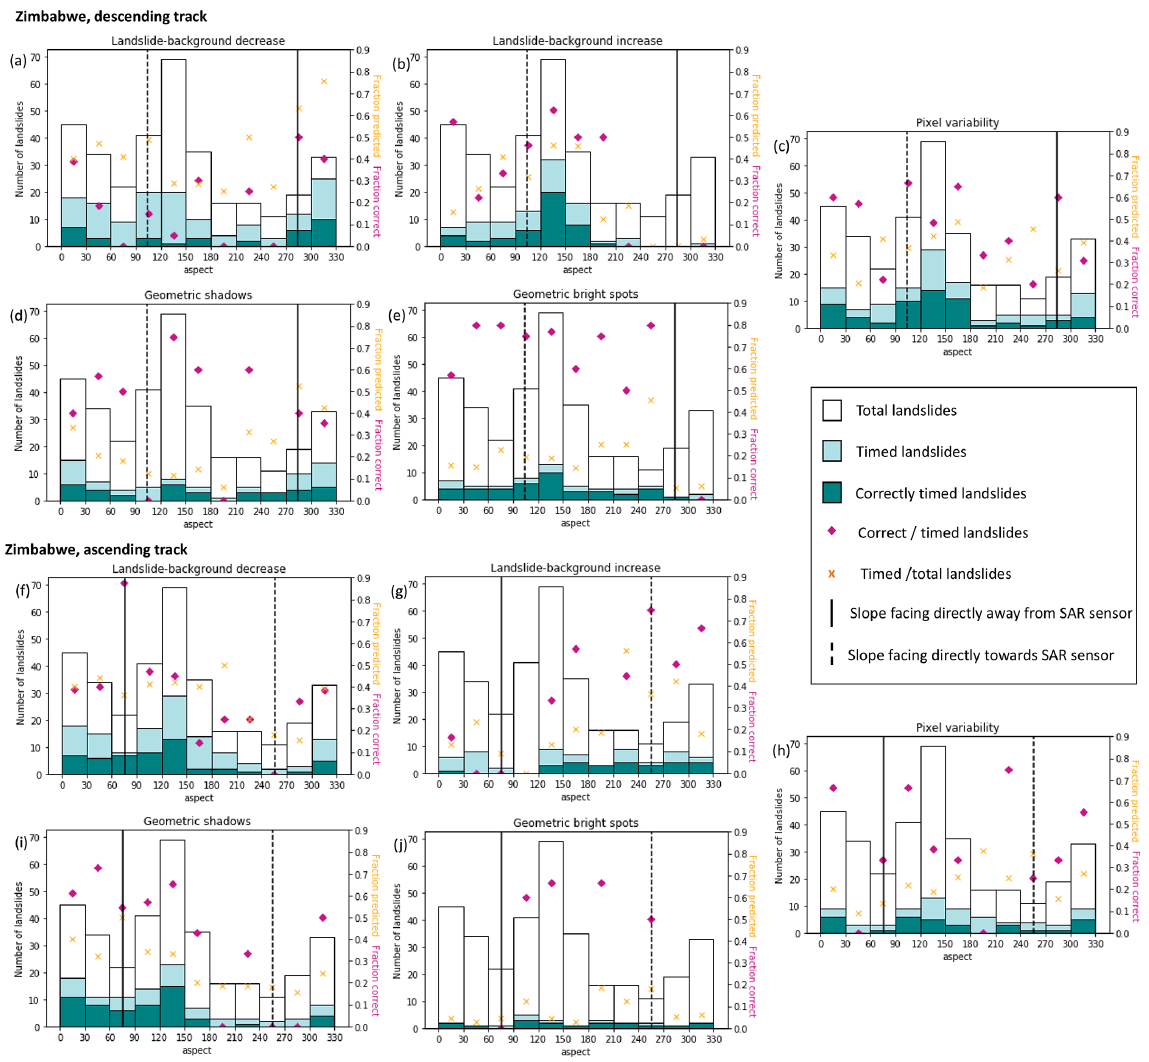
Figure 6. The distribution of total landslides (white), landslides assigned a time (light green) and landslides assigned the correct time (dark green) over aspect for each technique using ascending and descending track SAR over the Zimbabwe